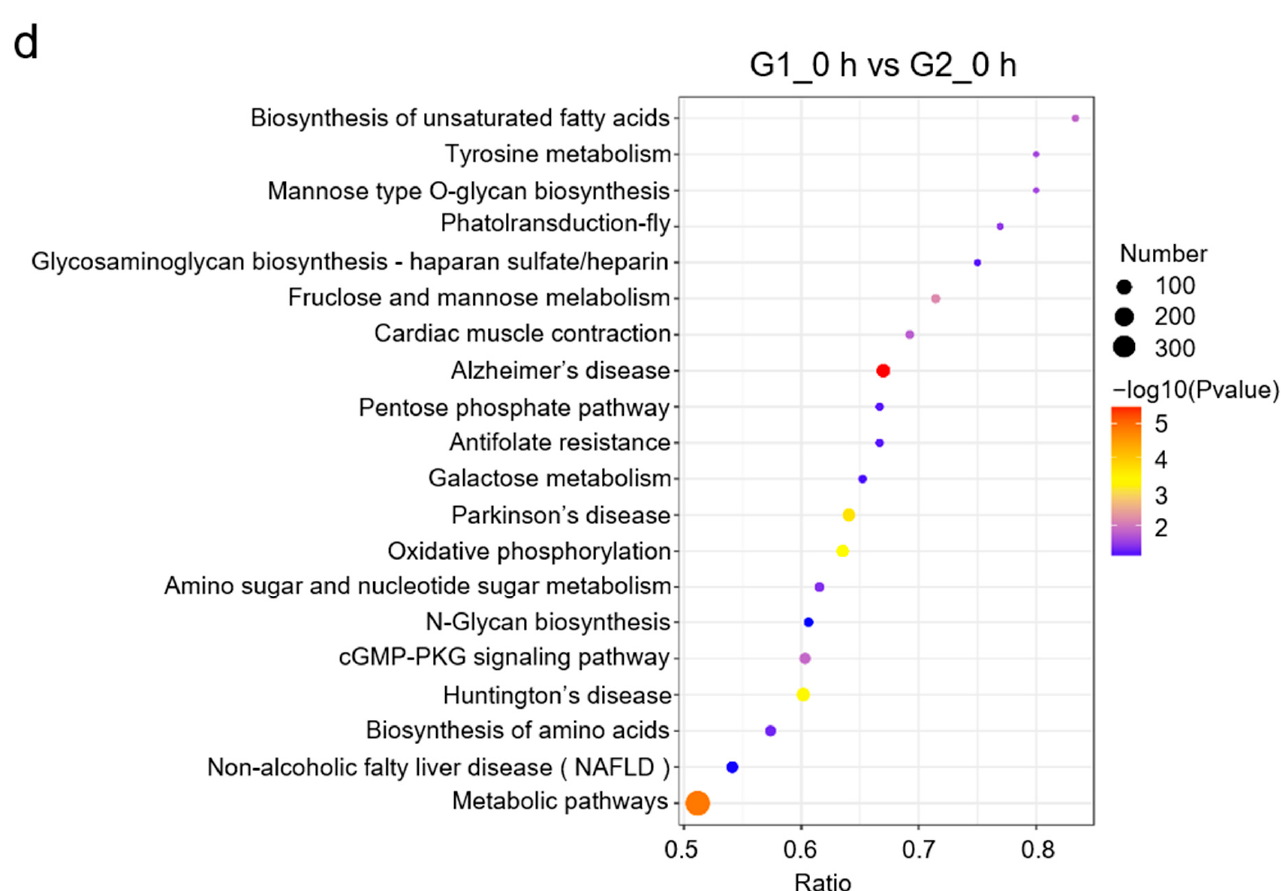
Figure 4. Proteomic analysis of animal-based enzymes and animal-origin-free enzymes. ( a ) Volcano plot of protein expression differences. G1 represents Group 1, which comprises 37 °C animal-based enzymes digesting Vero cells at 37 °C; G2 represents Group 2, which comprises 37 °C animal-origin- free enzymes digesting Vero cells at 37 °C. Green represents the weakly expressed proteins of G1_0h compared with G2_0h; red represents highly expressed proteins; black represents proteins with no significant difference in expression. ( b ) Differential clustering heatmap of protein expression. The horizontal axis represents the sample name and clustering results, and the vertical axis represents differentially expressed proteins and clustering results. Red and blue represent highly and weakly expressed proteins, respectively. ( c ) GO enrichment analysis histogram. The abscissa shows the functional description, and the ordinate shows the ratio of the number of differential proteins to the total number of differential proteins. CC (Cellular Component) stands for cellular component and is used to describe the subcellular structure, location, and macromolecular complexes, such as the nucleolus, telomeres, and complexes that recognize initiation; MF (molecular function) is used to describe the individual functions of genes and gene products, such as carbohydrate binding or ATP hydrolase activity, etc. BP (biological process) is used to describe the biological process in which the gene-encoded product participates, such as mitosis or purine metabolism. ( d ) KEGG pathway enrichment analysis bubble plot. The abscissa shows the ratio of the number of differential proteins to the total number of differential proteins, and the ordinate shows the functional